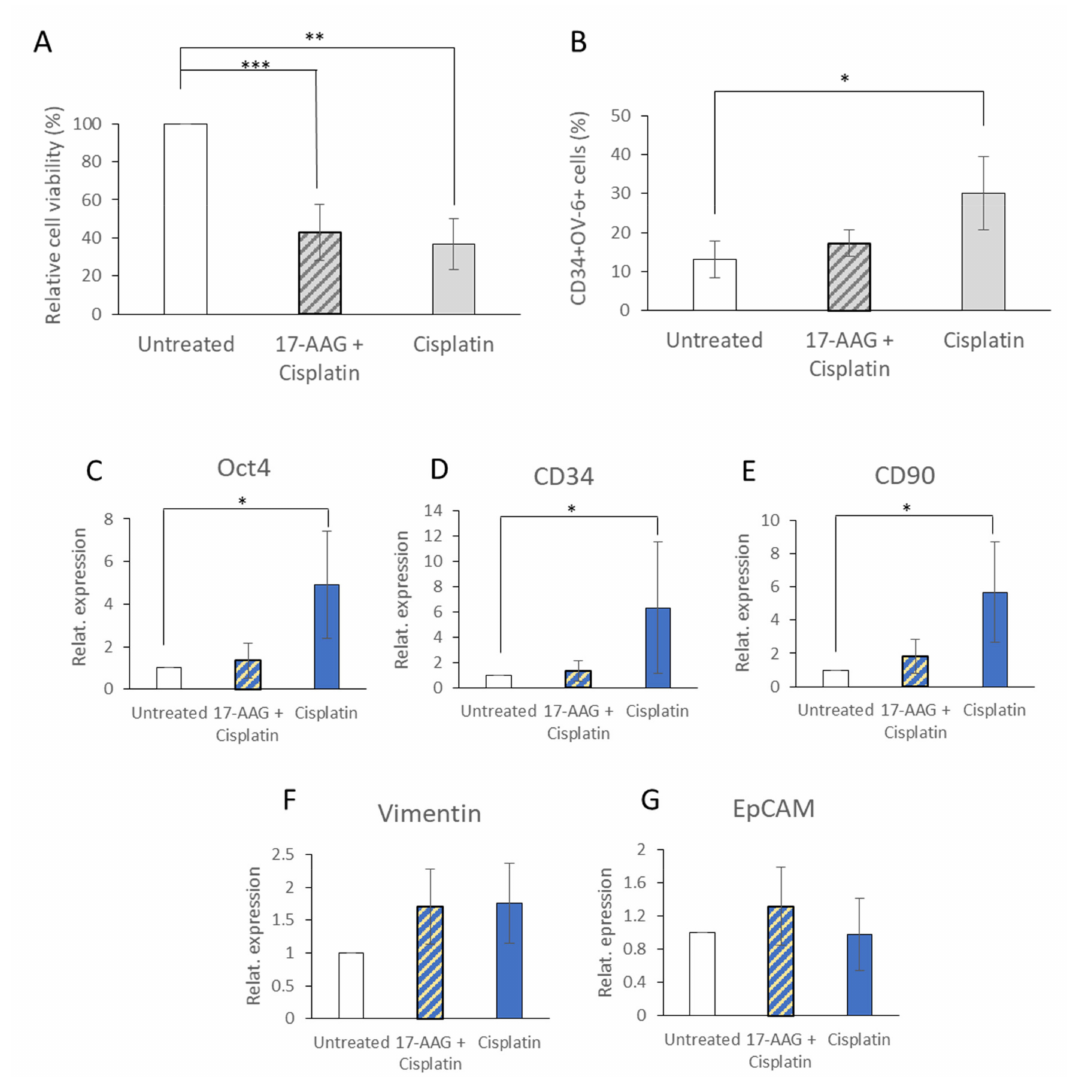
Figure 6. 17-AAG even showed its effect on Cisplatin-treated cells. HuH6 cells were pretreated with 0.1 µ M 17-AAG and subsequently with 2 µ g/mL Cisplatin or treated with 2 µ g/mL Cisplatin alone. ( A ) After 72 h of Cisplatin treatment, the cell viability was measured using MTT assays. The presented values are the means with error bars depicting the standard deviation from the mean. The assay was performed 4 times. Dunn’s multiple comparisons test was performed in order to calculate the significance of the data (* p < 0.05, ** p = 0.001–0.01, *** p = 0.0001–0.001). ( B ) Using flow cytometry, the expression of CD34 and OV-6 binding was measured in 5 independent experiments. The values represent the means and the error bars depict the standard deviation from the mean. Dunn’s multiple comparisons test was performed in order to calculate the significance of the data (* p < 0.05). ( C – G ) The expressions of Oct4, CD34, CD90, vimentin and EpCAM were evaluated using qPCR in 5 independent experiments. The presented values are the means and the error bars depict the standard deviation from the mean. Dunn’s multiple comparisons test was performed in order to calculate the significance of the data (* p <